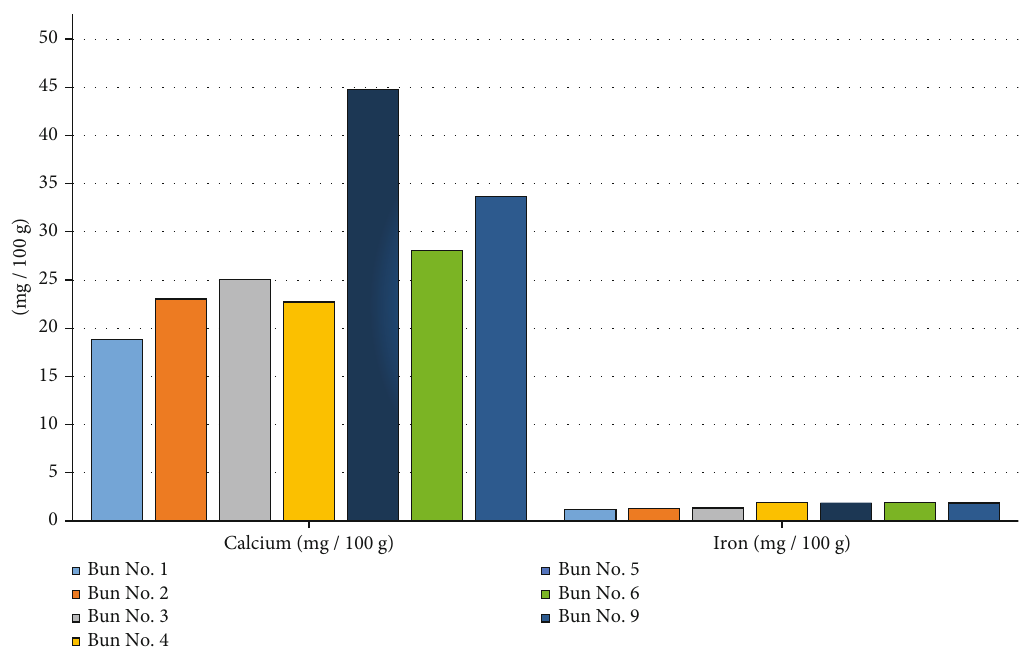
Figure 14: The content of calcium and iron in the composition of the various bun